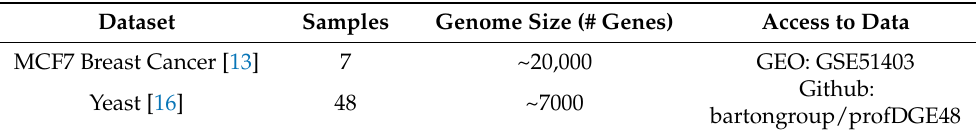
Table 2. The two isogenic datasets include a single individual’s gene expression dataset with 7 biological replicates while the second dataset has 48 wild-type and mutant biological replicates. Dataset Samples Genome Size (# Genes) Access to Data MCF7 Breast Cancer [13] 7 ~20,000 GEO: GSE51403 Github: Yeast [16] 48 ~7000